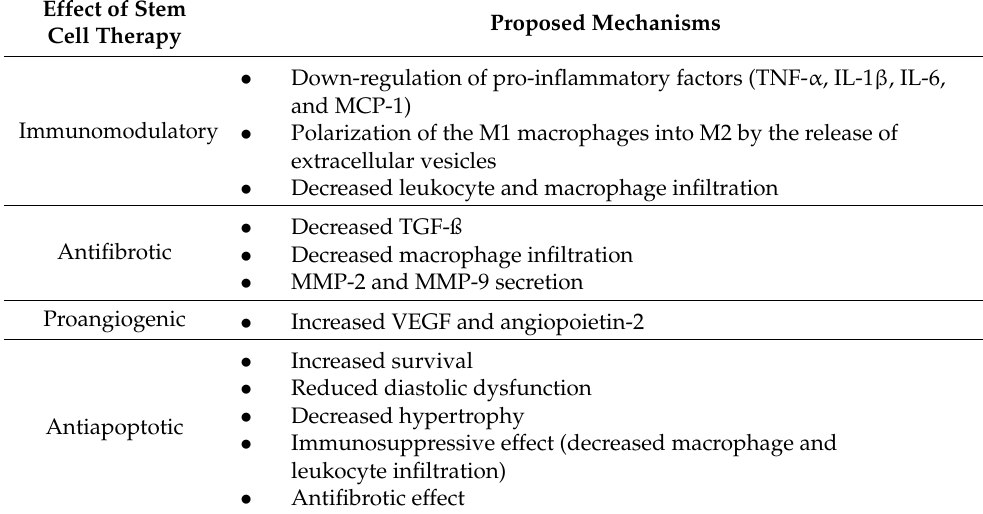
Table 2. Proposed mechanisms of stem cell therapy in